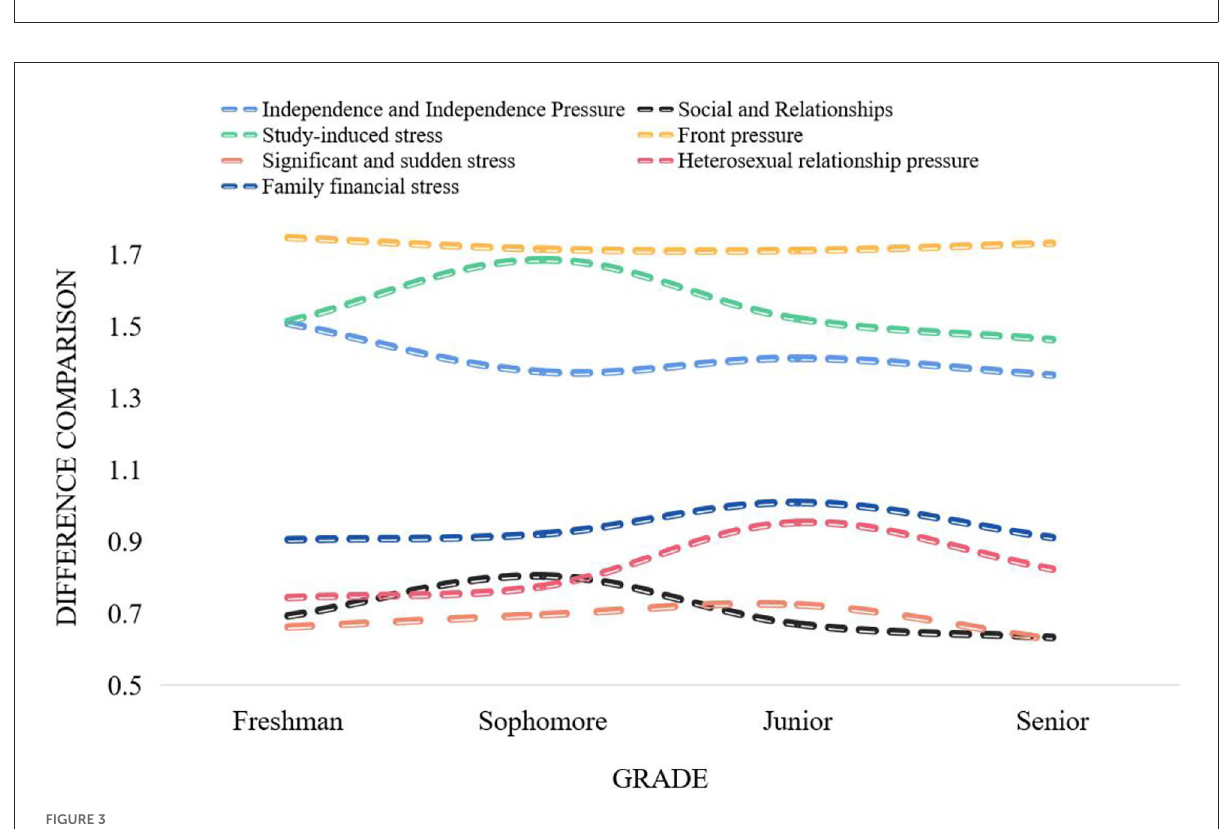
FIGURE3 Different stressors of college students in